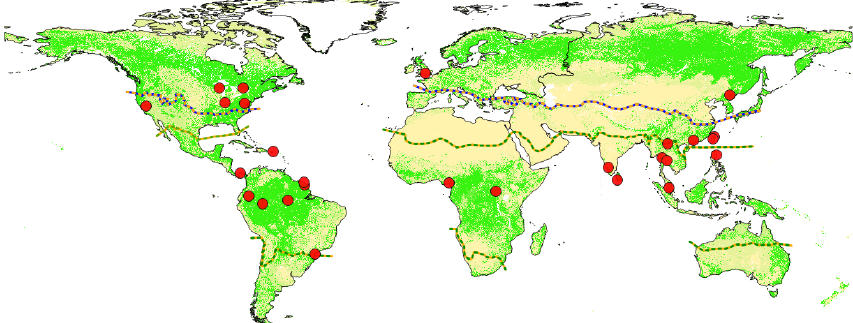
Figure 1. Geographical distribution of the 30 study sites (red points) included in the present study, relative to the global distribution of forest (green) from GLOBCOVER2009 (Bontemps et al., 2011), and the boundaries between temperate and subtropical areas (blue and orange dashed lines) and between subtropical and tropical areas (orange and green dashed lines) from Fischer et al. (2012). The four sites at Ituri (Democratic Republic of Congo) are represented by a single dot due to their proximity. Note that Fischer et al. (2012) classify the Yosemite site as subtropical, but we considered it as temperate due to its high elevation. Details on study sites are provided in Table